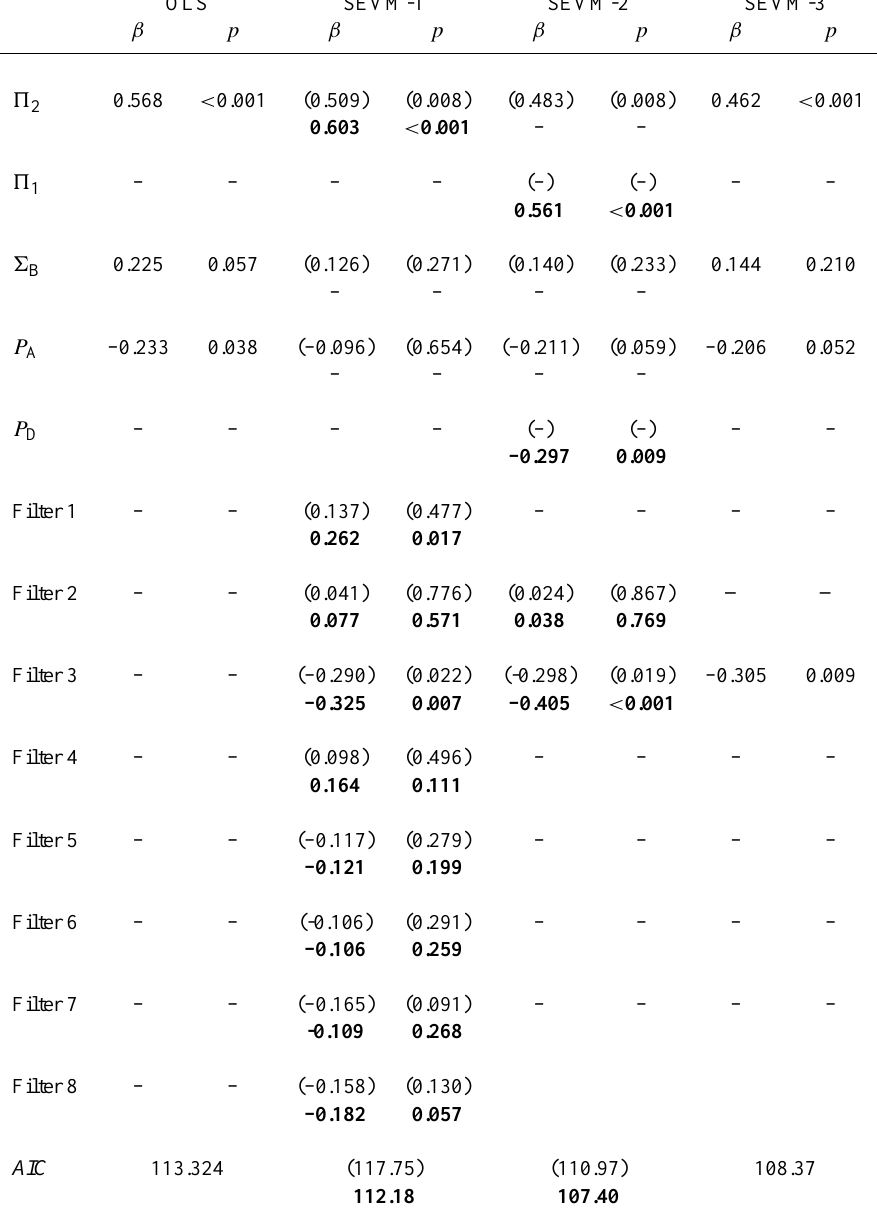
Table 6. Lowest AIC model fits for the prediction of stand turnover rate with and without the use of spatial filters. For each variable, the upper line gives first the standardised coefficients ( β ) and their level of significance ( p ) from the best OLS model fit followed by the results (in brackets) when the same OLS model is applied with the preselected spatial filter included. Also shown in bold (second line) for each variable are the values of β and p obtained for the lowest AIC model fit with the spatial filters included. Variables not included in any given model fit are denoted with a “–”. Variables: 5 2 ; Quesada et al. (2010)’s second index of soil physical properties: 5 1 ; Quesada et al. (2010)’s first index of soil physical properties; 6 B ; soil total sum of bases: P A ; mean annual precipitation: P D ; dry season precipitation. The numbering of the spatial filters is